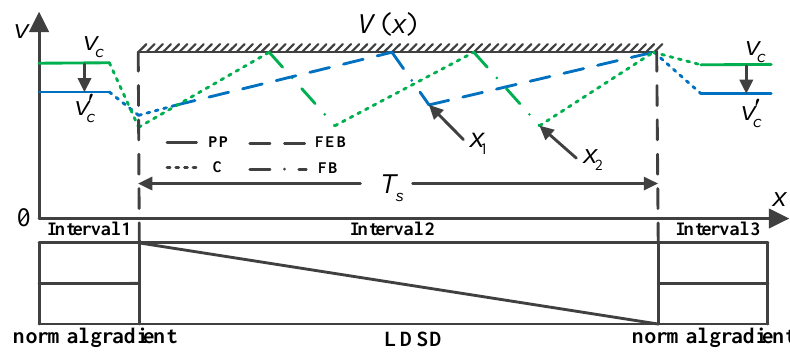
Figure 12. Interval time allocation and energy consumption.